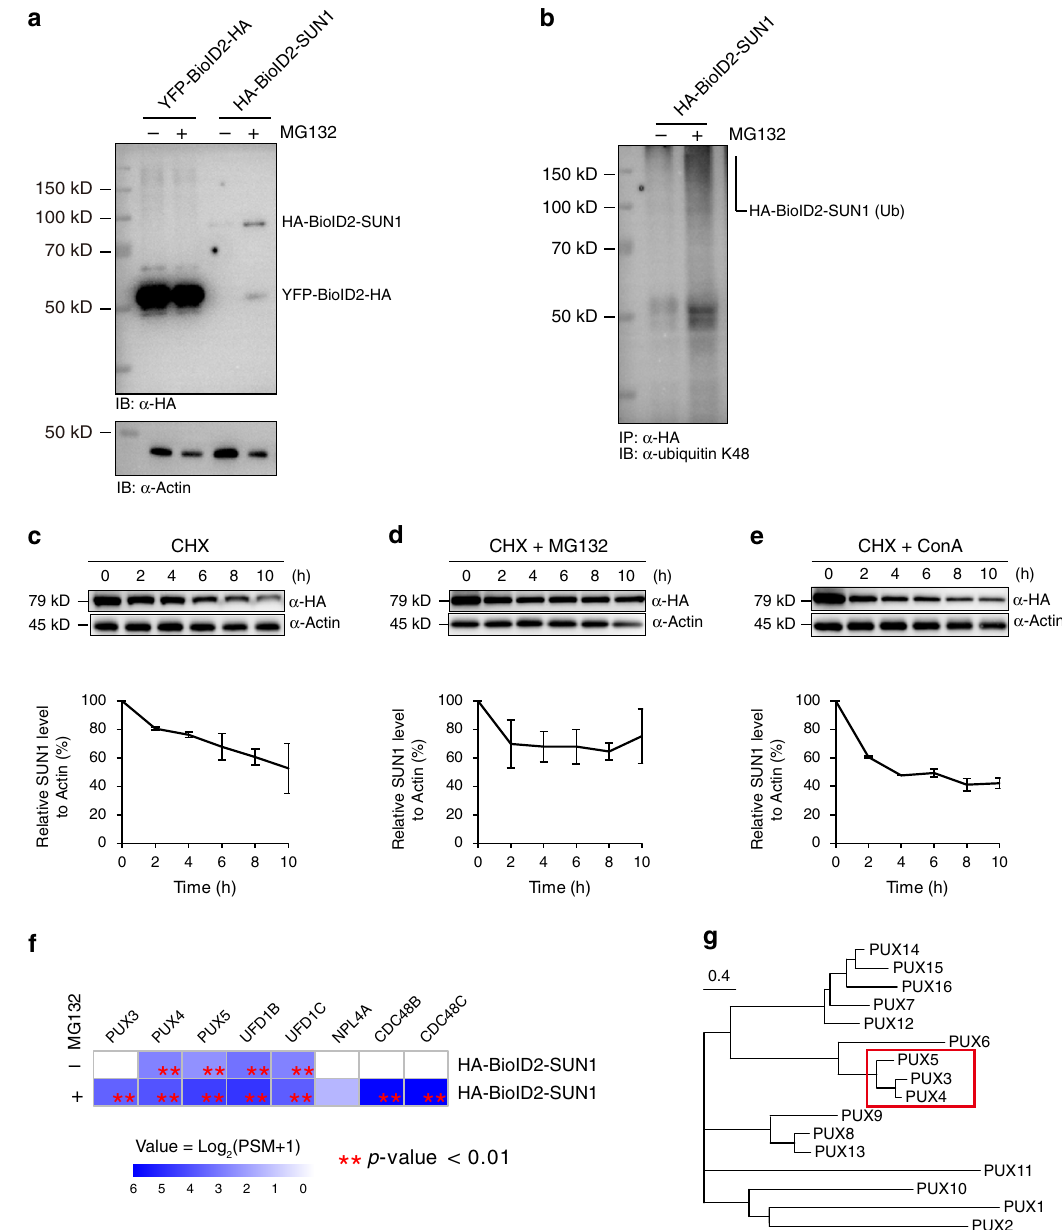
Fig. 2 SUN1 is subject to proteasome-dependent but autophagy-independent degradation. a Steady-state accumulation of HA-BioID2-SUN1. Ten-day- old 35S: HA-BioID2-SUN1 seedlings were treated with or without 50 μ M MG132 for 8 h before total protein was extracted and immunoblotted with anti-HA and anti-actin antibodies. The 35S: YFP-BioID2-HA transgenic plants were used as the control. b Total protein from the mock-treated or MG132-treated 35S: HA-BioID2-SUN1 seedlings was fi rst immunoprecipitated with anti-HA antibody-coated agarose beads and then immunoblotted with anti-ubiquitin antibody (K48 linkage). c In vivo protein degradation assay for HA-BioID2-SUN1. Ten-day-old seedlings expressing HA-BioID2-SUN1 were treated with 100 µ M CHX for the indicated times before total protein was extracted and immunoblotted with anti-HA and anti-actin antibodies. d In vivo HA-BioID2-SUN1 degradation was blocked when 50 µ M MG132 was used to treat plants together with CHX. e In vivo HA-BioID2-SUN1 degradation was not affected when 1 µ M ConA was used to treat plants together with CHX. c – e The lower panels are densitometric analyses of HA-BioID2-SUN1 protein levels using actin as the control. Error bars represent standard deviations (SD) from two independent biological replicates. f Transformed and averaged PSM values of the CDC48 complex components and PUX3/4/5 from PL-LFQMS pro fi ling using 35S: HA-BioID2-SUN1 plants with or without MG132 treatment. Two biological replicates were used. Asteriks (**) represents signi fi cant enrichment with p -value < 0.01 (linear model F -test) compared to controls. g Phylogenetic analysis of 16 PUX members in Arabidopsis . The neighbor-joining tree was generated using amino acid sequences. Bar corresponds to substitution per